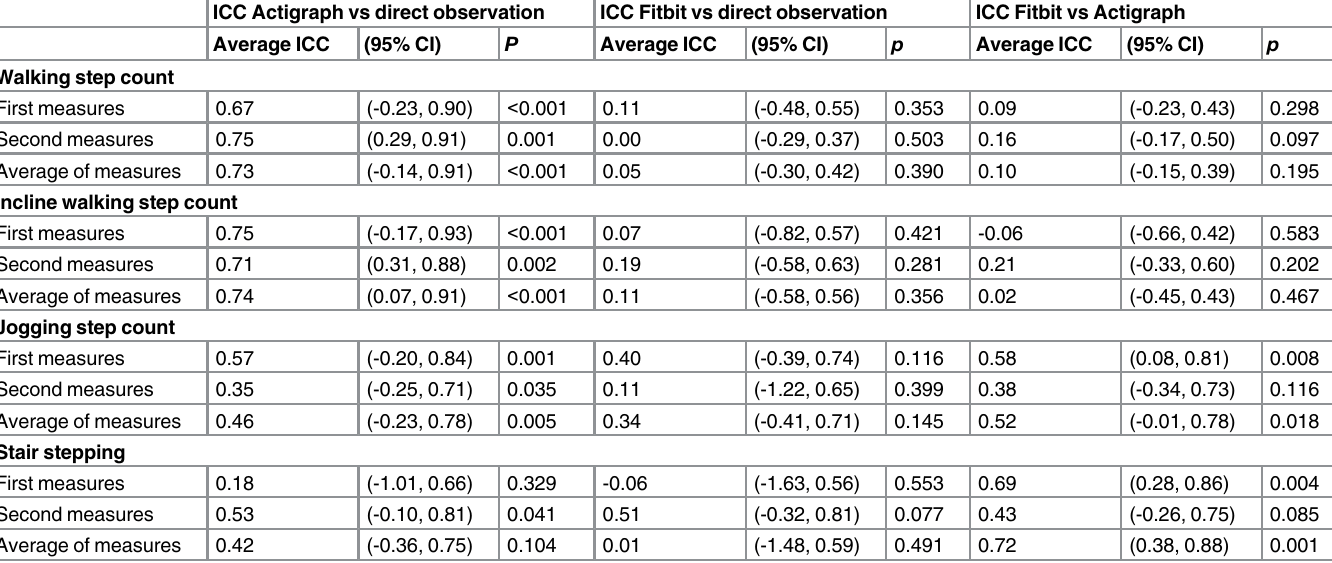
Table 3. Intraclass correlations between Fitbit and Actigraph and between devices and direct observations.